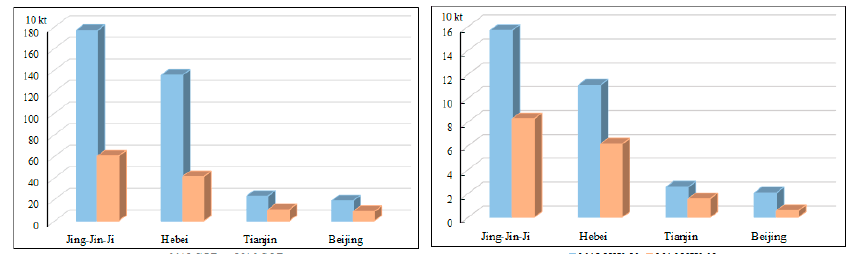
Figure 2. Schematic of water pollutant discharge in Beijing City, Tianjin City, and Hebei Province in 2012 and 2016.